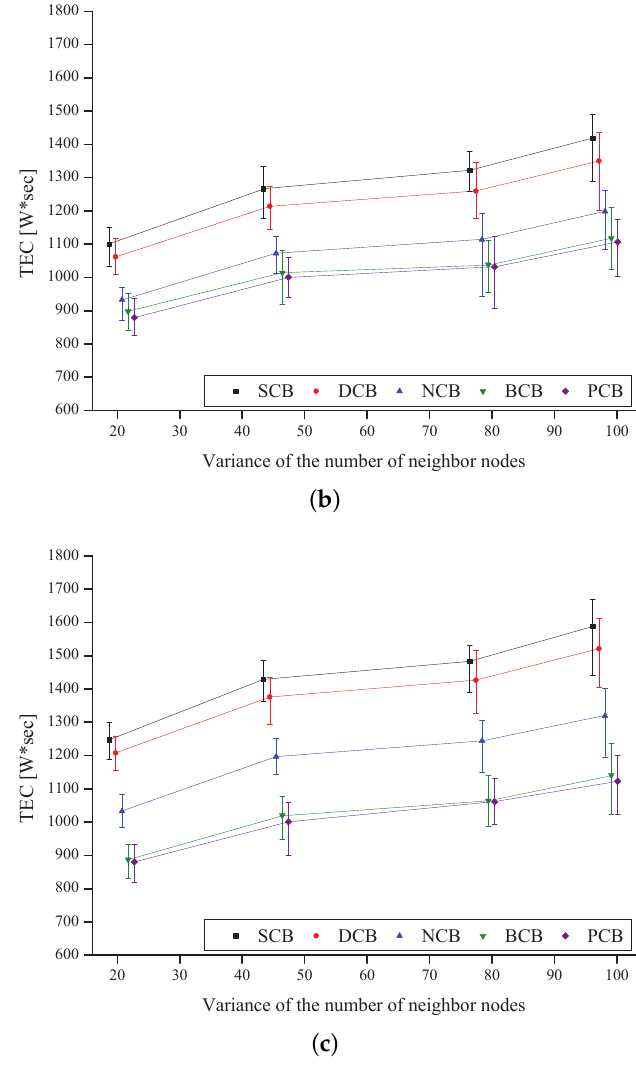
Figure 14. Total energy consumption ( TEC ) as a function of the variance of the number of neighbor nodes. ( a ) C max = 3; ( b ) C max = 4; ( c ) C max =